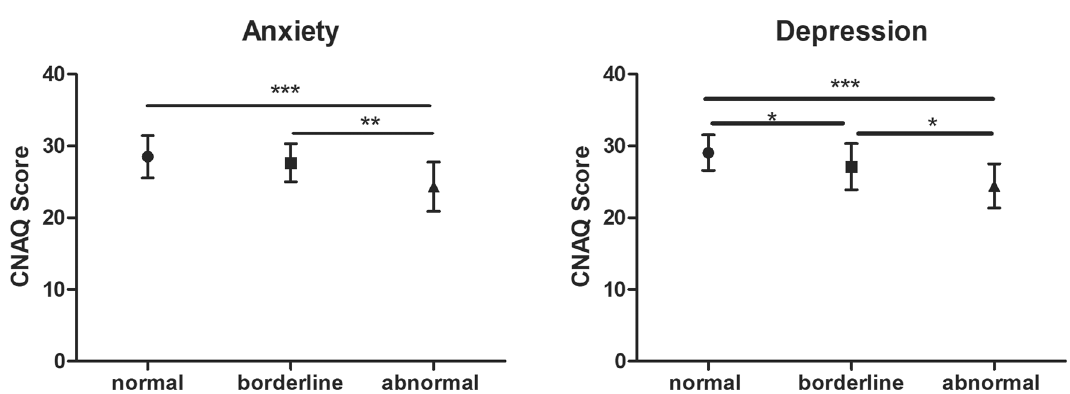
Figure 1. According to the score of HADS-A and HADS-D, separated the patients into normal, borderline and abnormal groups, CNAQ scores of normal, borderline and abnormal groups were compared. *p < 0.05; **p < 0.01; ***p <